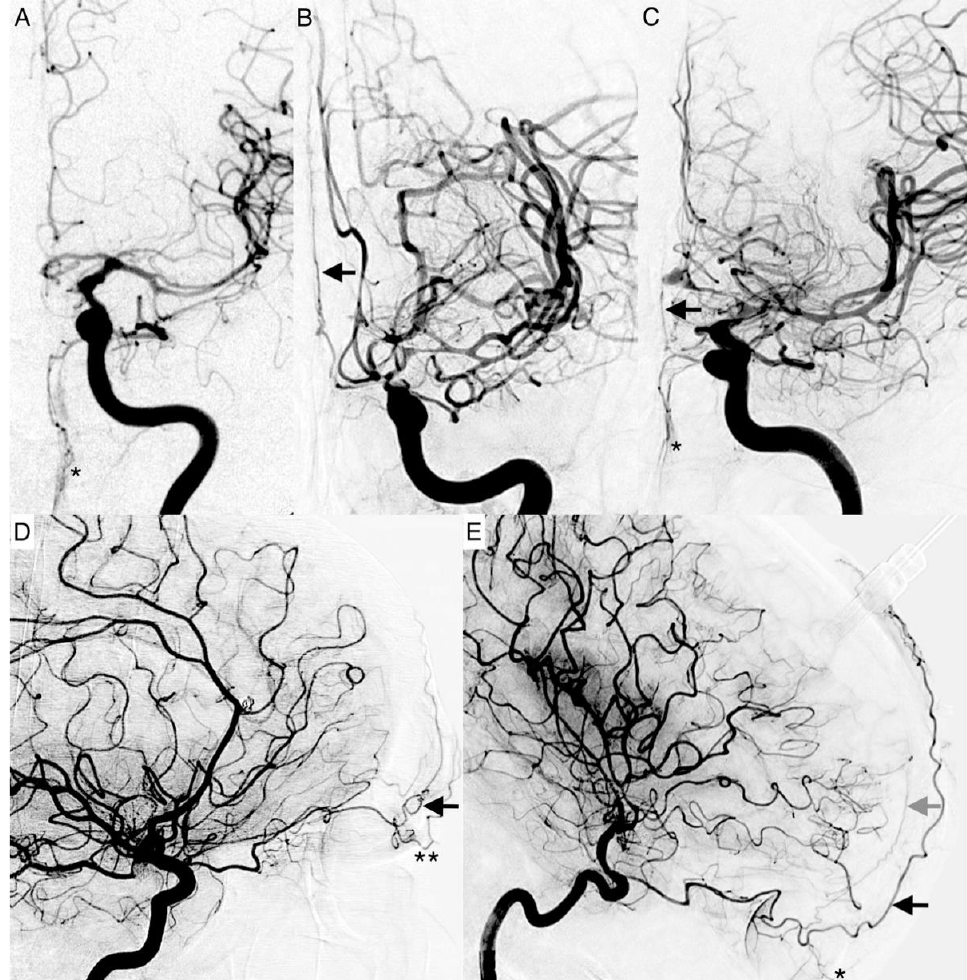
Figure 2. Angiograms of enlarged terminal branches of the ophthalmic artery. Posterior-anterior projections: ( A ) The dorsal nasal artery (DNA, single star) is shown as prominent terminal branch in moderate vasospasm. ( B ) The supratrochlear artery (STA, black arrow) enlarged in severe vasospasm with a ghost sign of the carotid T. The A2 segment of the anterior cerebral artery is not present. ( C ) Severe vasospasm with a positive twisted T-sign of the DNA (single star) and the STA (black arrow). Lateral projections: ( D ) Constitutional prominent STA (black arrow) and supraorbital artery (double stars) on admission. ( E ) Enlarged STA (black arrow), DNA (single star) and prominent anterior falx artery (AFA, gray arrow) in high-grade vasospasm with narrowing of the terminal internal carotid artery.